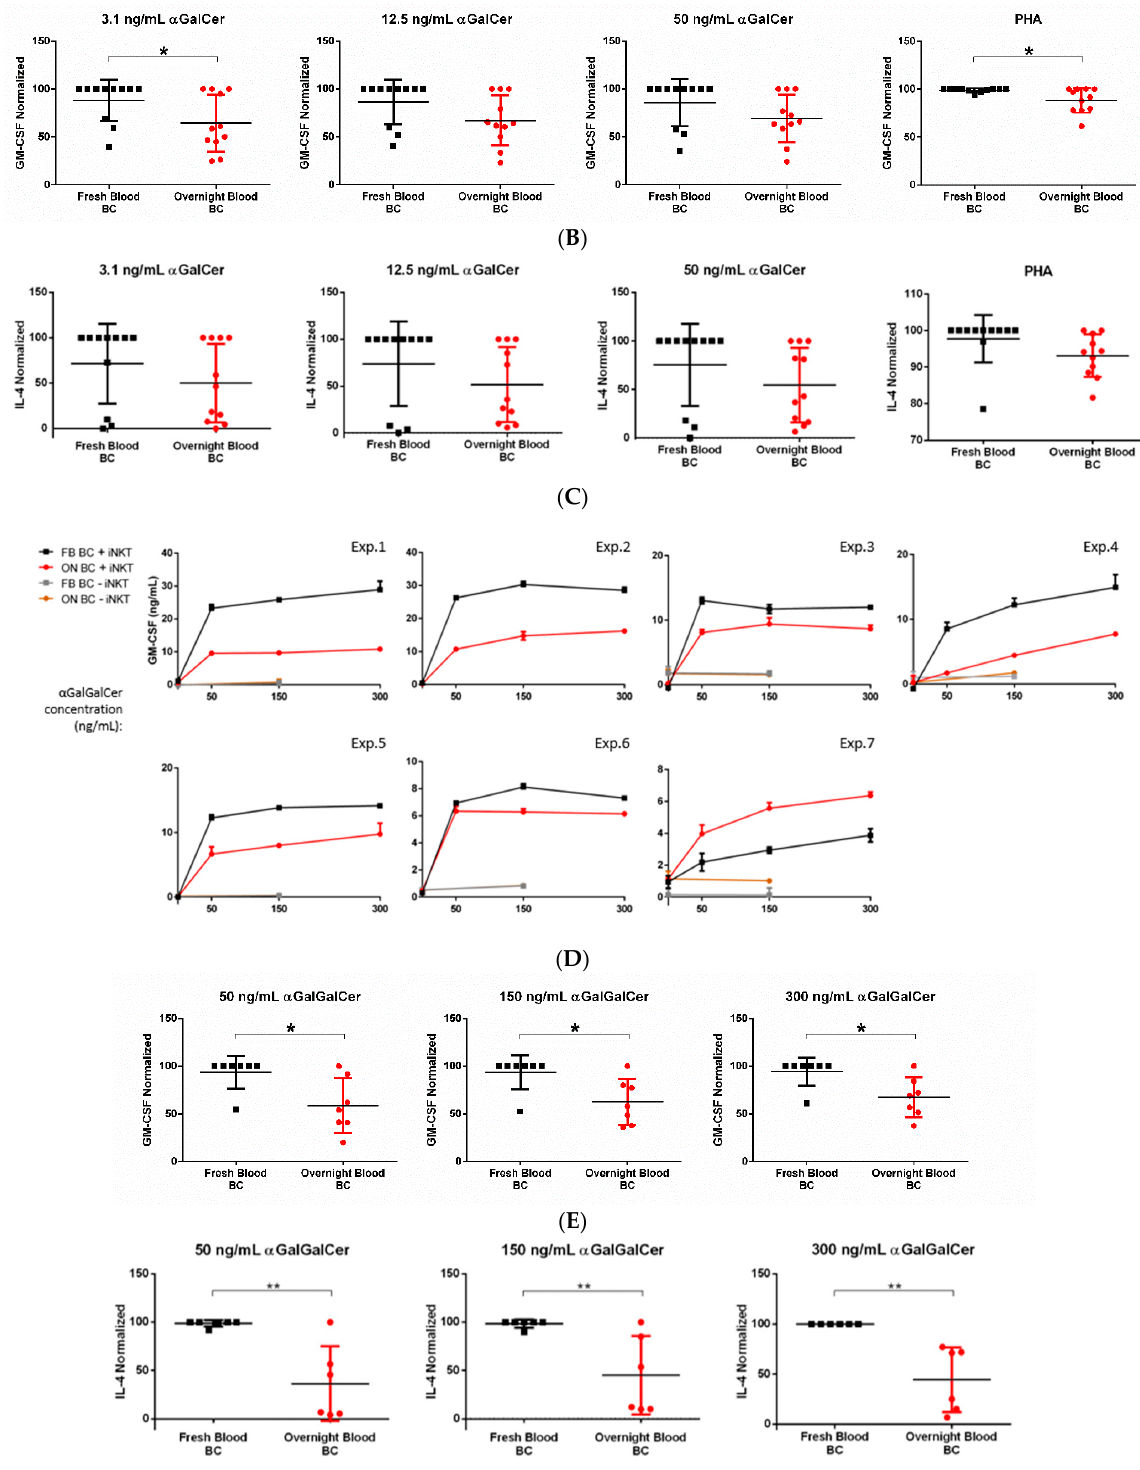
Figure 2. Monocytes isolated from Fresh Blood Buffy Coats have a higher capacity to present lipid antigens by CD1d than monocytes isolated from Overnight Blood Buffy Coats. Monocytes were incubated with 3.1, 12.5, and 50 ng/mL of α -GalCer, or 50, 150, and 300 ng/mL of α -GalGalCer, or 1 µ g/mL PHA and cultured with and without iNKT cells. The iNKT cell response was analyzed by measuring GM-CSF and IL-4 release to the supernatant by ELISA. Black lines and square-shaped dots:Fresh Blood Buffy Cots (FB BC); red lines and circle dots:Overnight Blood BC (ON BC). ( A )